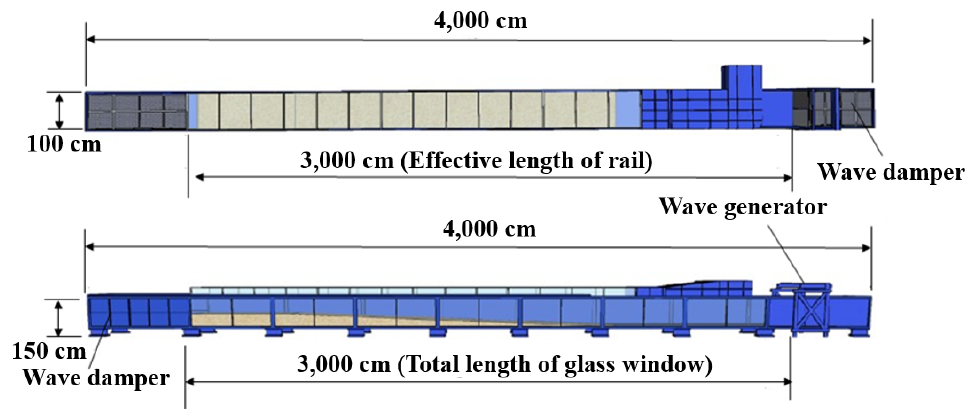
Figure 1. Wave flume used in the hydraulic model experiment.